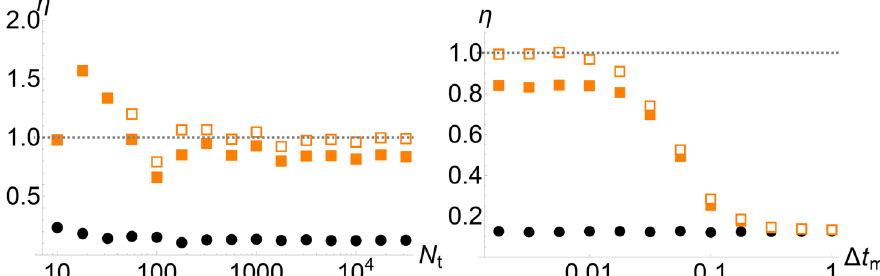
FIG. 7. Different estimates on the entropy production as a function of various simulation parameters for the particle in a tilted periodic potential. In all panels, the black dots correspond to the ratio η J [see Eq. (48)] for the TUR, the filled orange squares to the ratio η J;Z for the CTUR, with the observable Z being the integral over the inverse occupation fraction, and the empty orange squares to the ratio η J; ˜ Z ˜ Z with the numerically optimized observable . The parameter values are U 0 ¼ 1 , L ¼ 1 , F 0 ¼ 5 , μ ¼ 1 , and T ¼ 0 . 2 ; the length of the observation interval is τ ¼ 100 . The left shows the ratios as a function of the number of trajectories for a sampling interval Δ t m ¼ 0 . 01 , the right as a function of the sampling interval for N t ¼ 5000